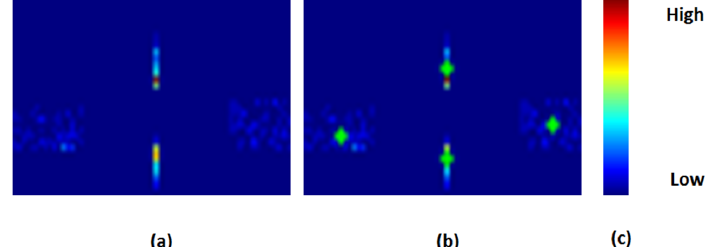
Figure 11. Eye shape voting procedure. ( a ) The distribution of the markers obtained through the voting of the fittest b = 30% hypotheses; cold colors represent smaller values and warm color represent higher values. ( b ) The solution control points (marked in green) computed as the weighted average of the fittest hypotheses. The intersection between the lower and the upper parabola is computed so that the solution can be expressed through the eye corners and two points on the upper and lower eyelids; and ( c ) color scale.